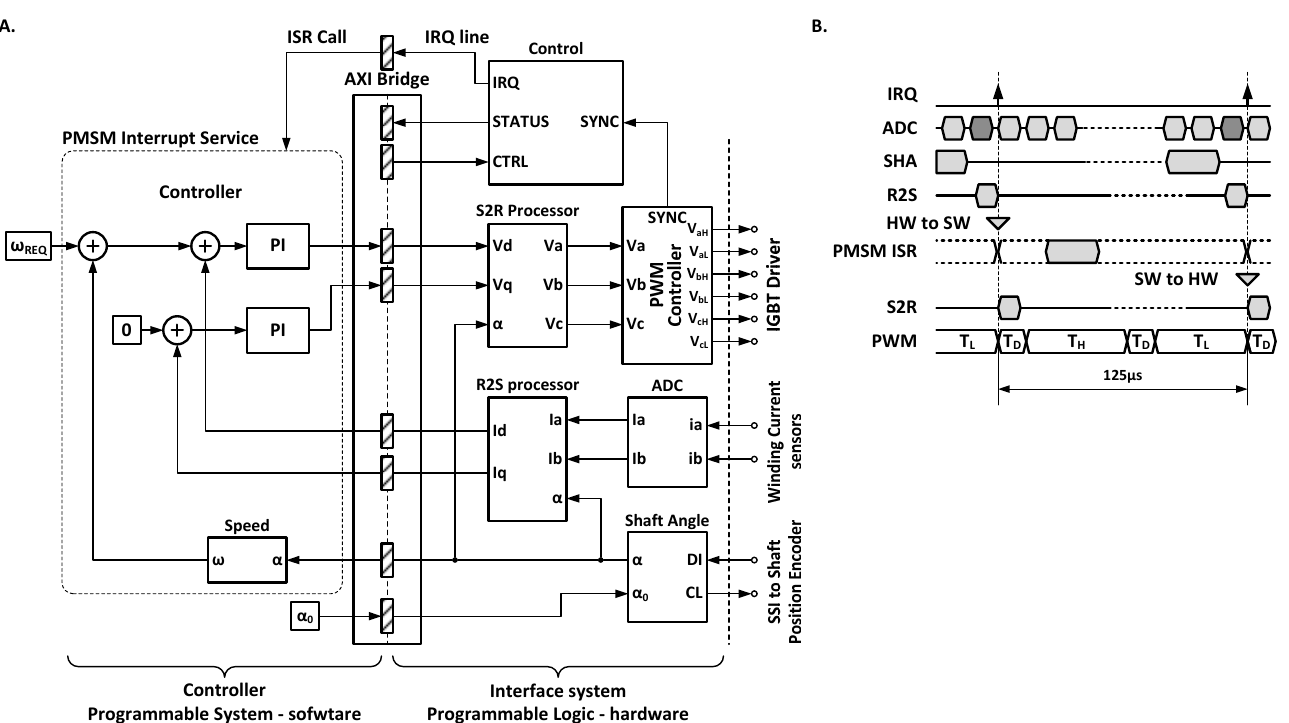
Figure 3. The block diagram of the hardware-software based controller implemented using ZYNQ programmable system on chip ( A ) and its operation schedule ( B ).